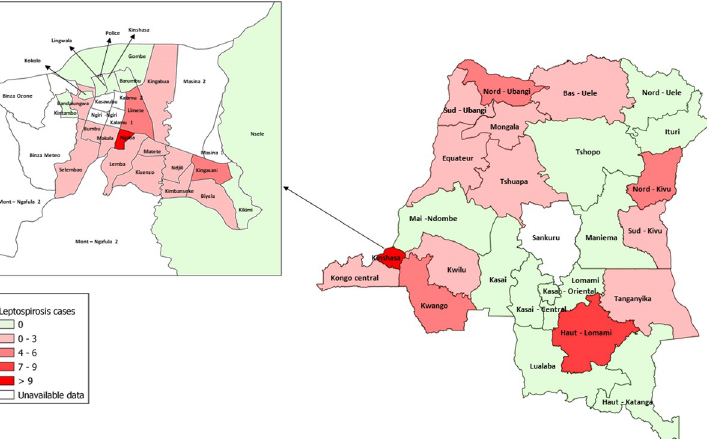
Fig 1. Map of positive leptospiral IgM cases distribution by province of the Democratic Republic of the Congo. The provinces in which positive cases were detected are shaded in red, and provinces are shaded in green that reported suspected cases of yellow fever. (Source: The map was created with the provincial Shapefile obtained from the free, open, collaborative platform Common geographical reference of DRC (https://datacatalog.worldbank.org/ dataset/democratic-republic-congo-administrative-boundaries-2017) accessed on April 25th,2020. The map was created using QGIS software (QGIS 3.14) geographical information system).